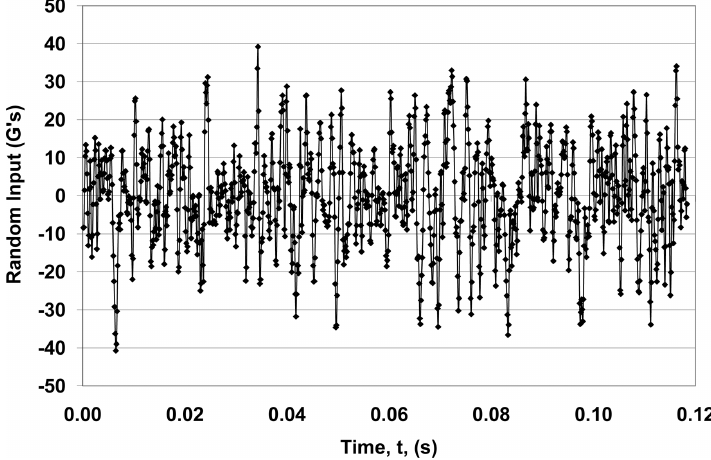
Fig. 4. Finite duration realization of a stationary random